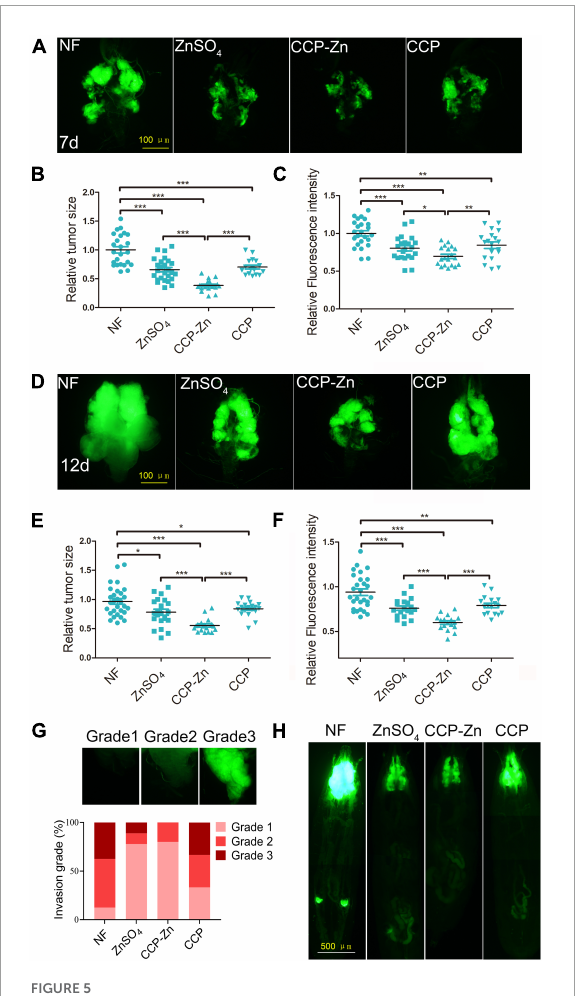
FIGURE5 The anti-tumor activity of CCP-Zn is higher than CCP or ZnSO 4 . (A) Compared with tumor control, ZnSO 4 , CCP, or CCP–Zn alleviated tumor growth in the cephalic complex at day 7 after egg laying (AEL). (B,C) Quantification of tumor size and fluorescence intensity in the cephalic complex at day 7 AEL. n = 15. (D) Compared with tumor control, ZnSO 4 , CCP, or CCP–Zn alleviated tumor growth and invasion in the cephalic complex at day 12 AEL. (E,F) Quantification of tumor size and fluorescence intensity in the cephalic complex at day 12 AEL. n = 15. (G) Quantification of the degree of tumor invasion at day 12 AEL. n = 15. (H) Compared with tumor control, ZnSO 4 , CCP, or CCP–Zn alleviated tumor growth and invasion in the whole body at day 12 AEL. Data are represented as mean ± SEM of the biological replicates. * p < 0.05, ** p < 0.01, *** p < 0.001; two-tailed Student’s t